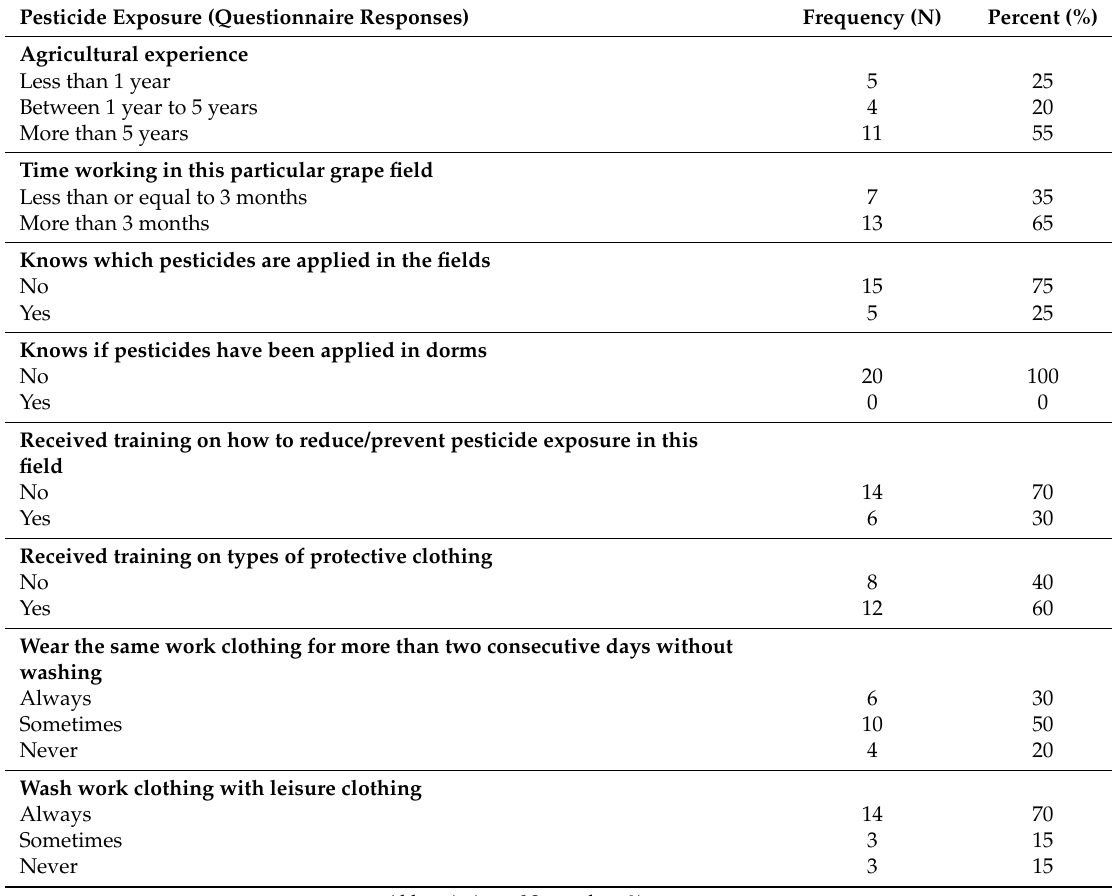
Table 3. The pesticide exposure of participants ( N = 20) based on self-reported